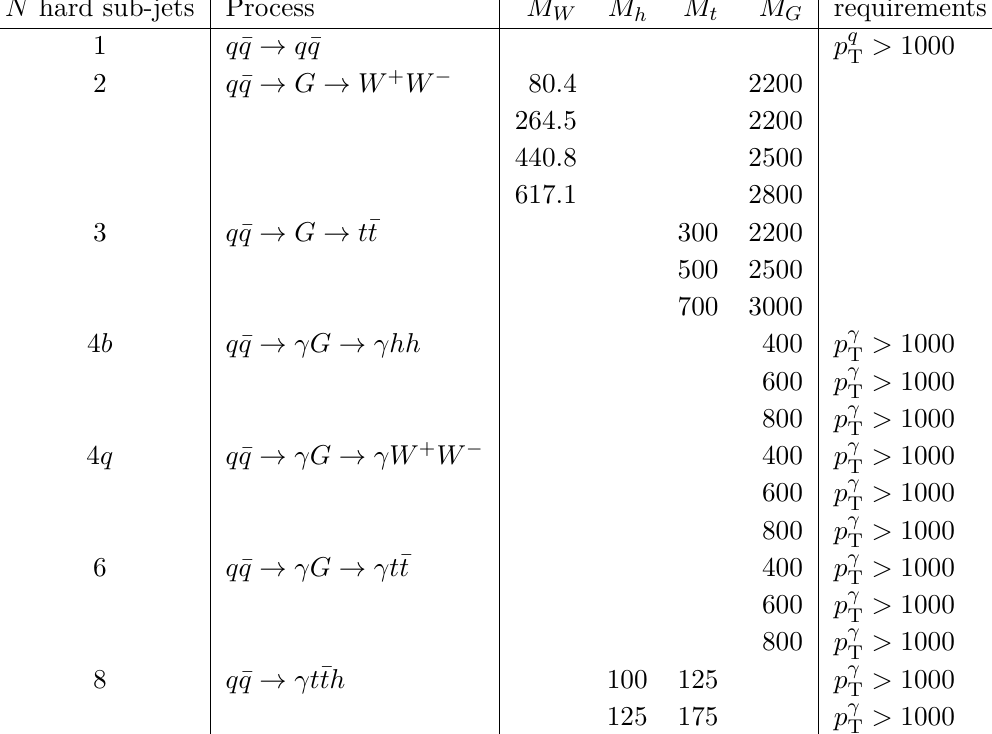
Table 1 . Processes used to generate jets with N = 1 , 2 , 3 , 4 b, 4 q, 6 , 8 hard sub-jets. Also shown are the particle masses and generator-level requirements used to more efficiently produce jets with p T ∈ [1000 , 1200] GeV and mass ∈ [300 , 700] GeV. All masses and momenta are in GeV. Selected W boson masses of (264.5,440.8,617.1) correspond to M Z = (300 , 500 , 700) , respectively. See figure 1 for the corresponding Feynman